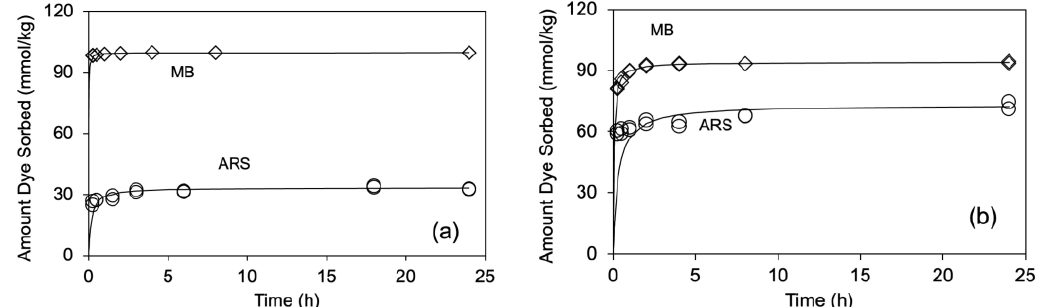
Figure 3. Kinetics of MB (diamond) and ARS (circle) sorption on the HNC from single ( a ) and binary ( b ) solutions. The lines are pseudo-second-order and fit the observed data.